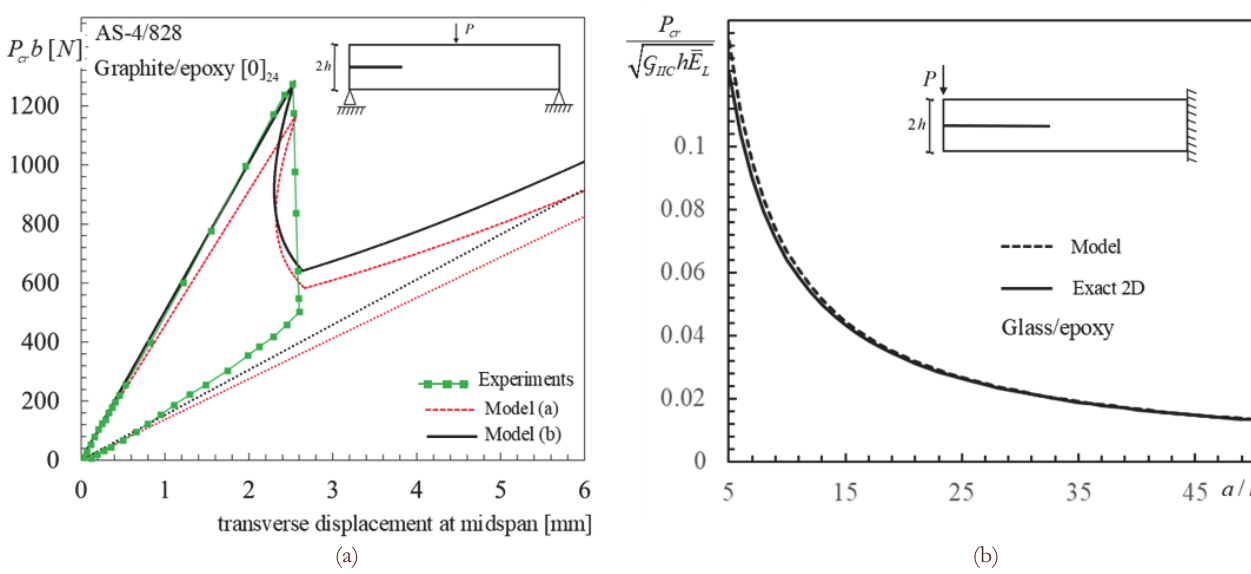
Figure 5: (a) Critical load for crack propagation versus load point displacement in a ENF specimen (modified after [18] ). Geometry and materials: L = 50 mm, 2 h = 3.4 mm,